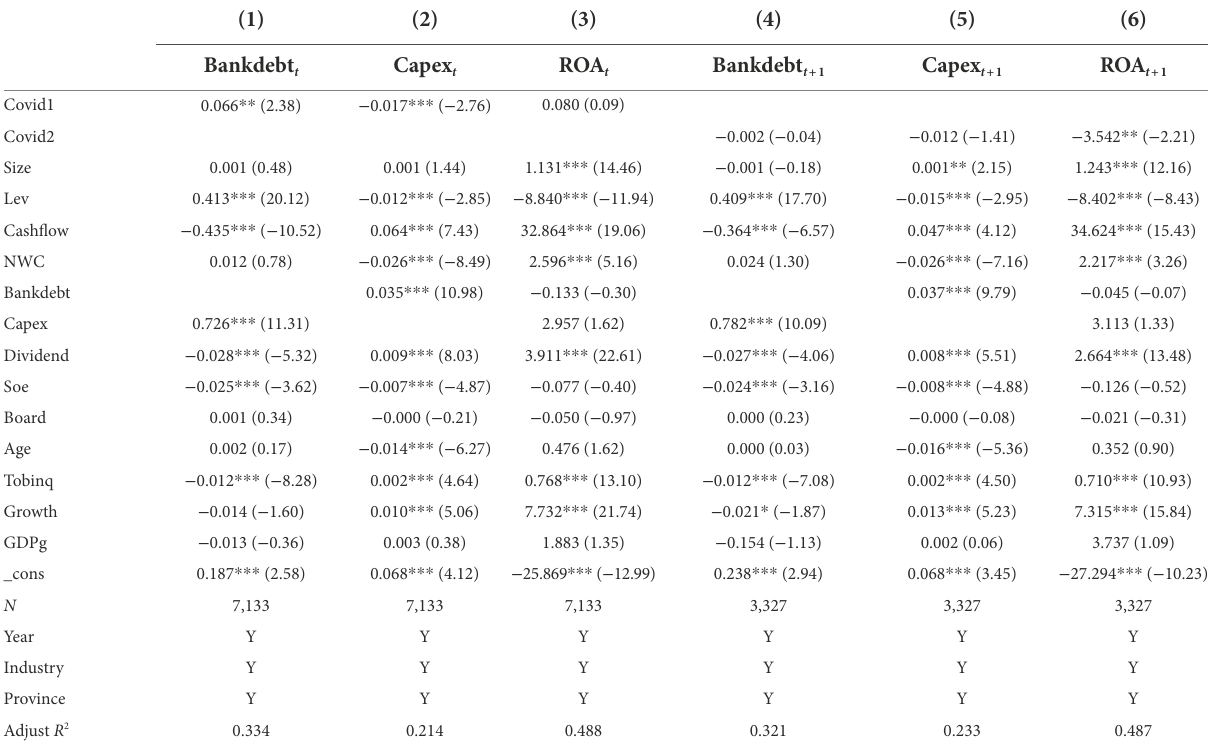
TABLE 3 The COVID-19 impact and financing, investment, and total asset return.